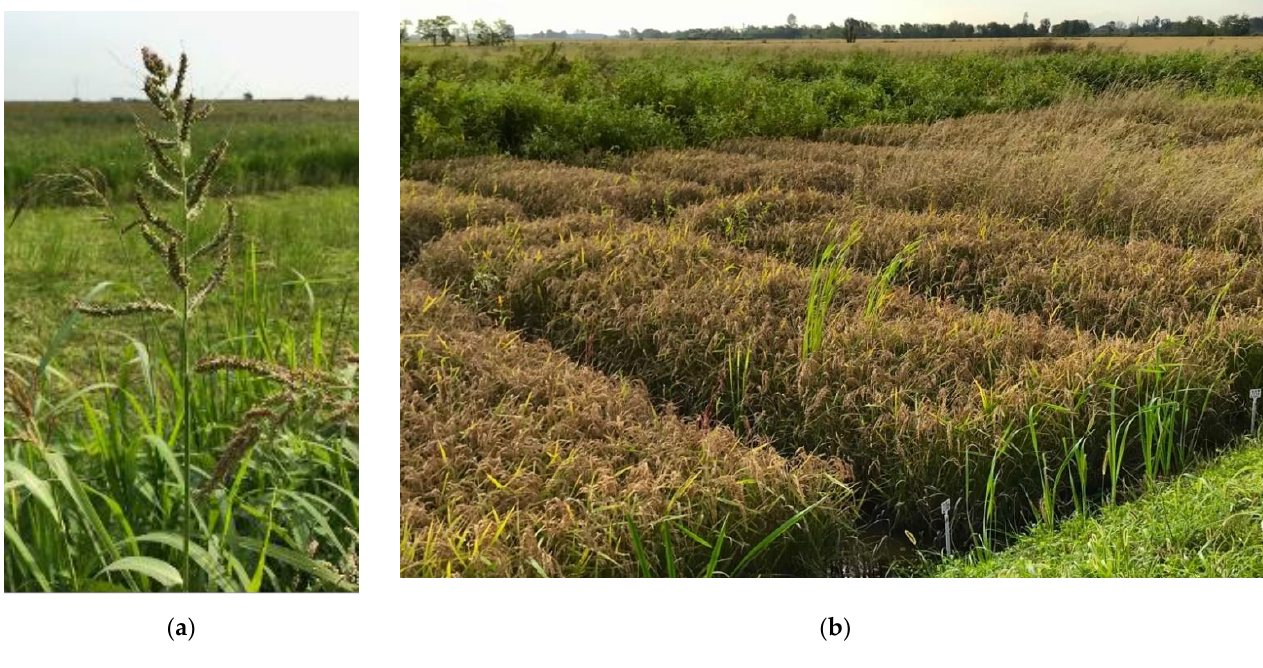
Figure 1. Picture of: ( a ) Echinochloa crus-galli panicle; ( b ) experimental parcel with Echinochloa crus-